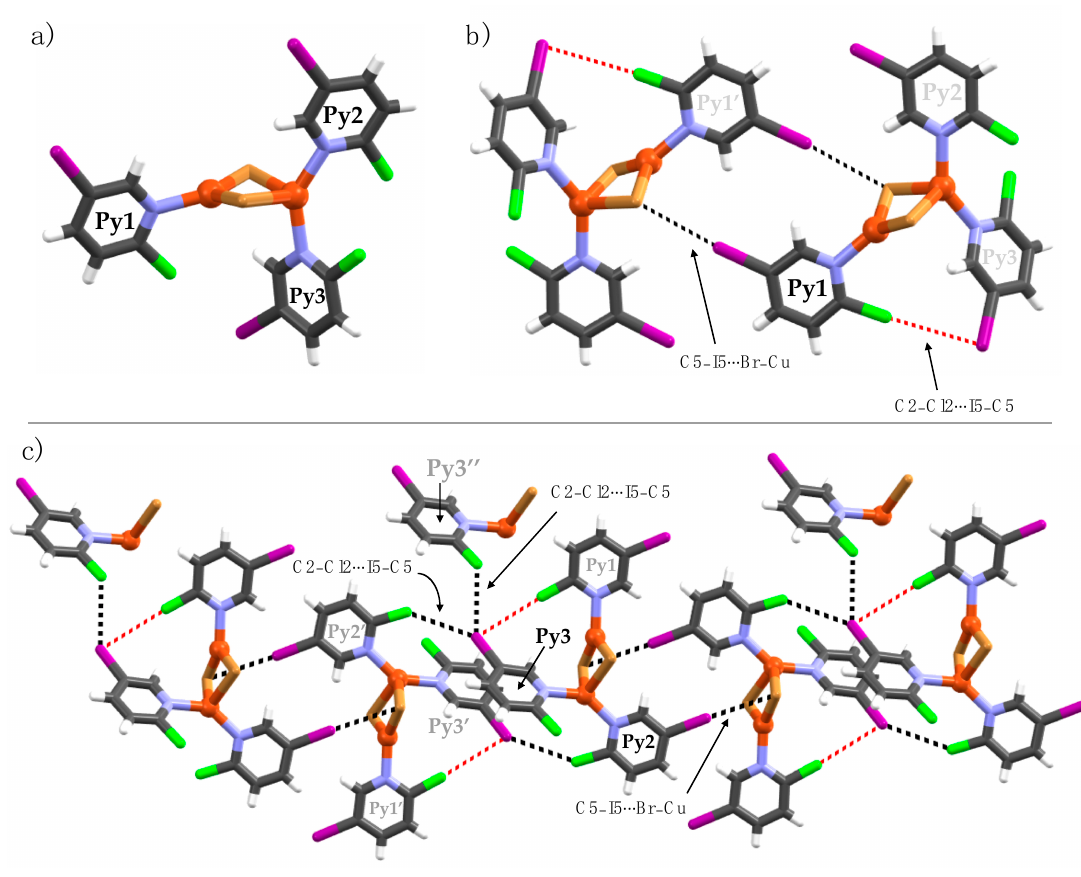
Figure 7. Crystal structure of 2b . Halogen bonds are depicted as black and red dotted lines focusing on ( a ) Py1, ( b ) Py2 and ( c ) Py3.